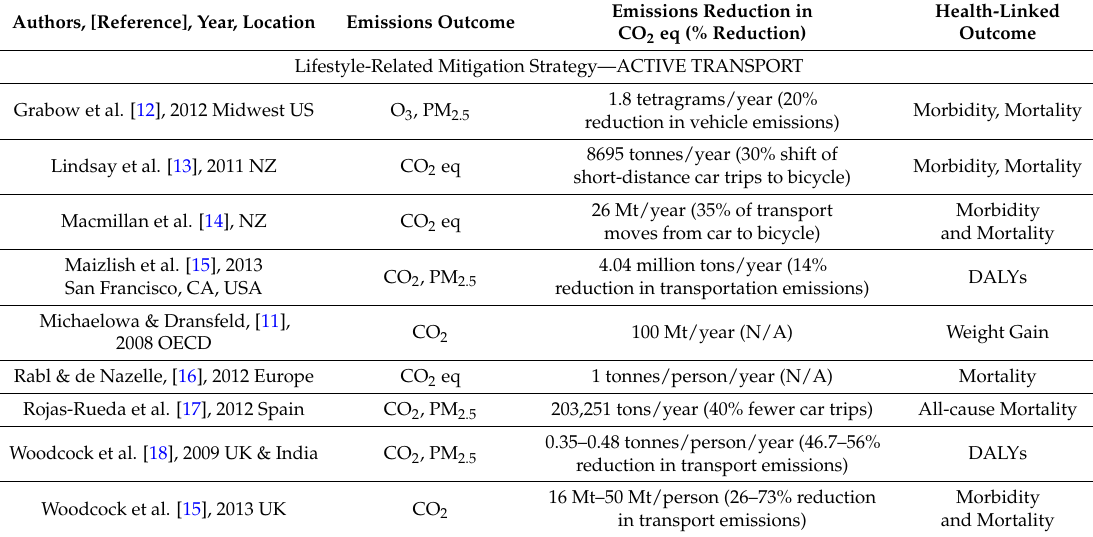
Table 2. Included articles, inclusion criteria, and emissions reduction